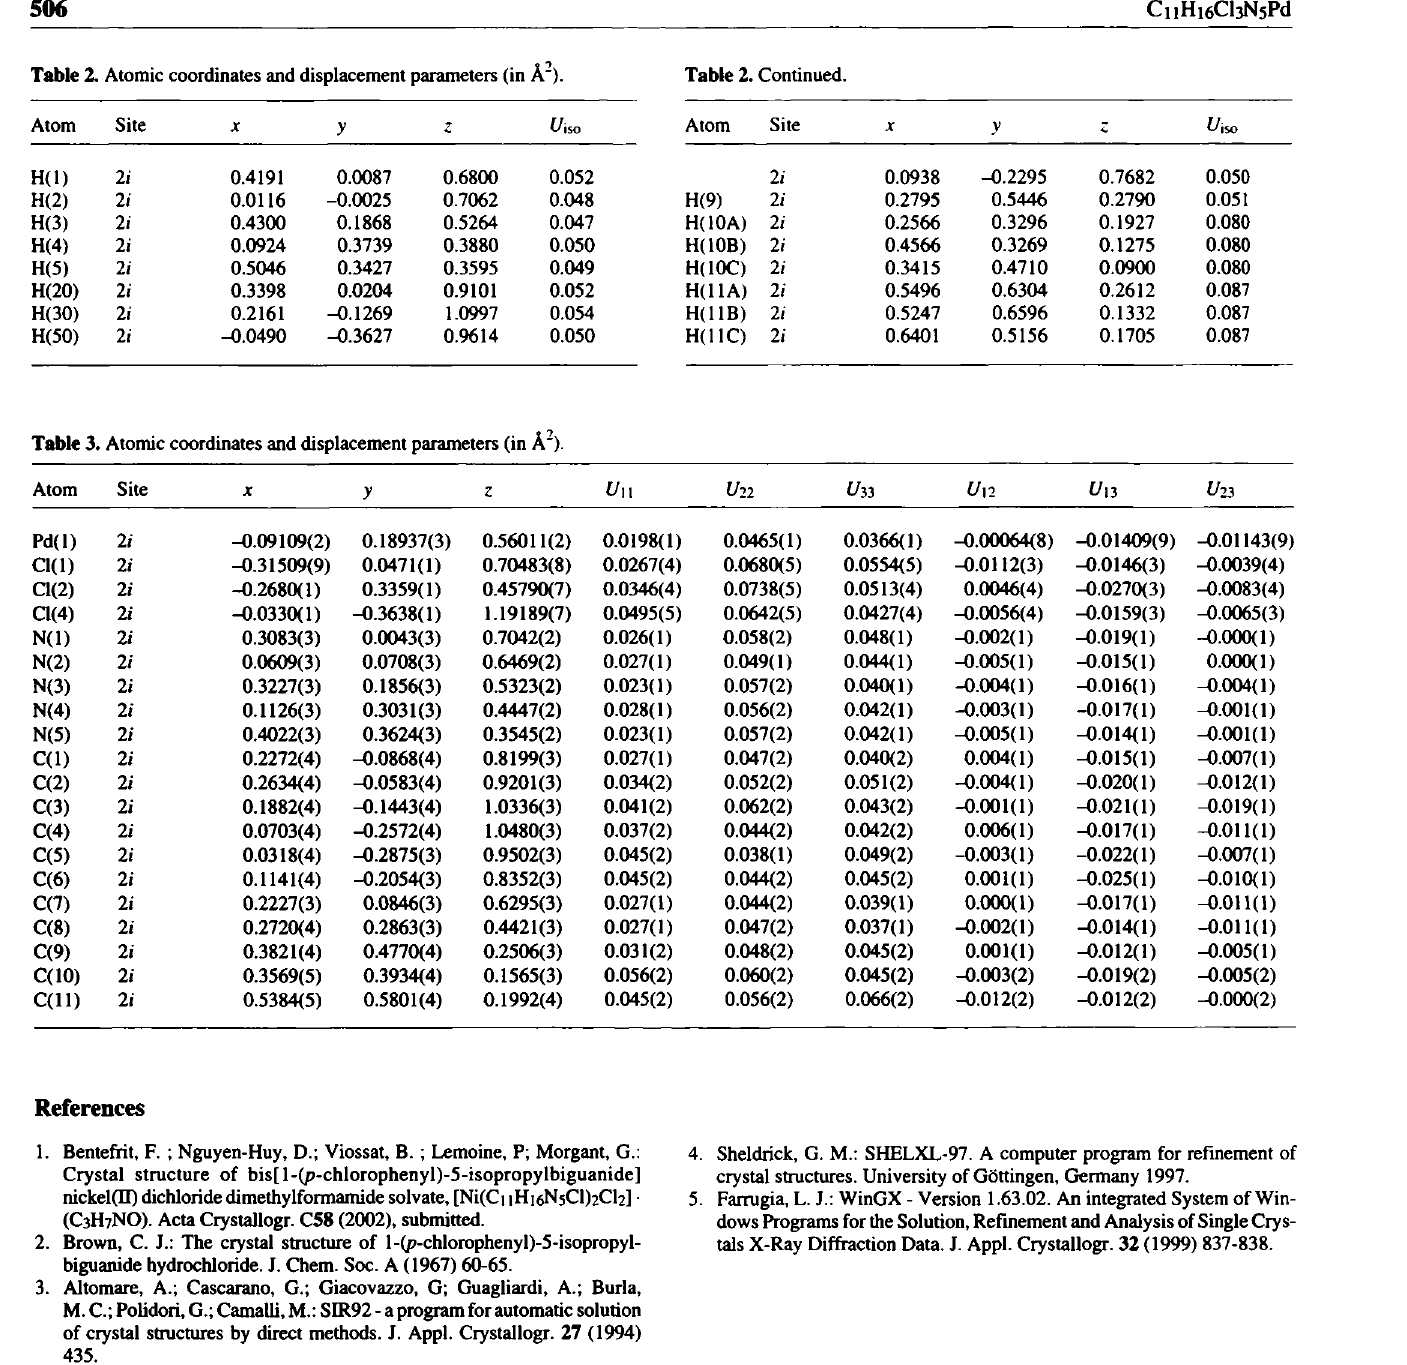
Table 2. Atomic coordinates and displacement parameters (in Â 2 ).